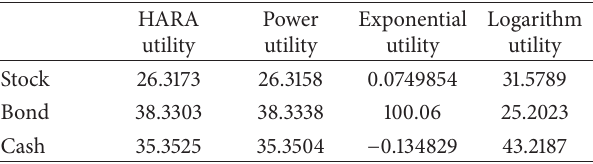
Table 2: The optimal policy only with affine interest rate.